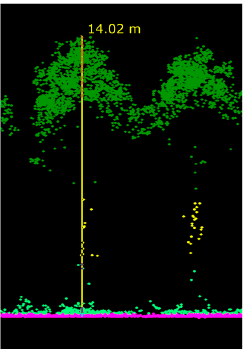
Figure 5. Example of the tree height measuring method.